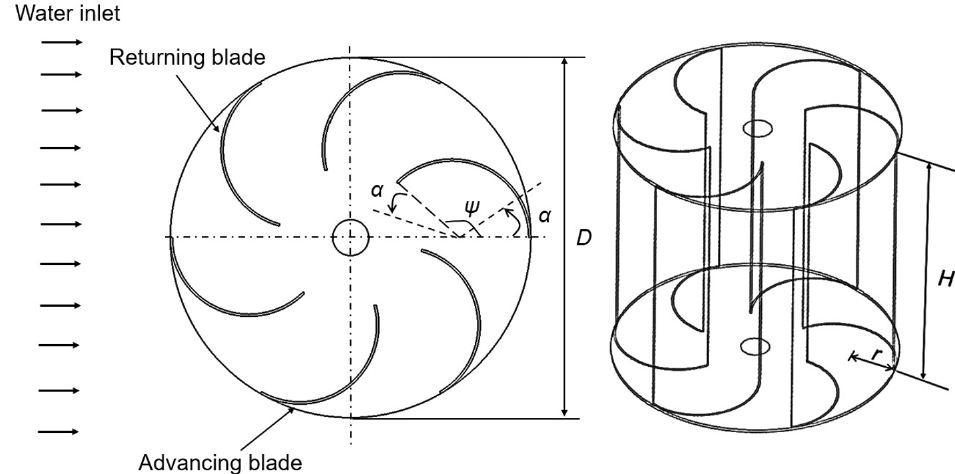
Figure 1. Schematic diagram of a 6-bladed turbine.